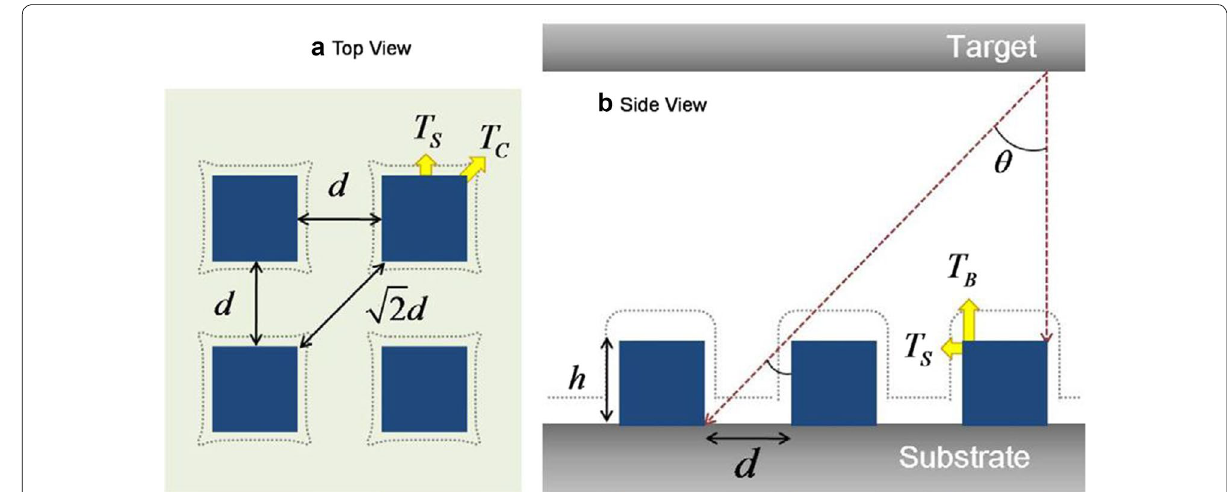
Fig. 5 Schematic representation of geometric factors considered when calculating sidewall thickness [48]